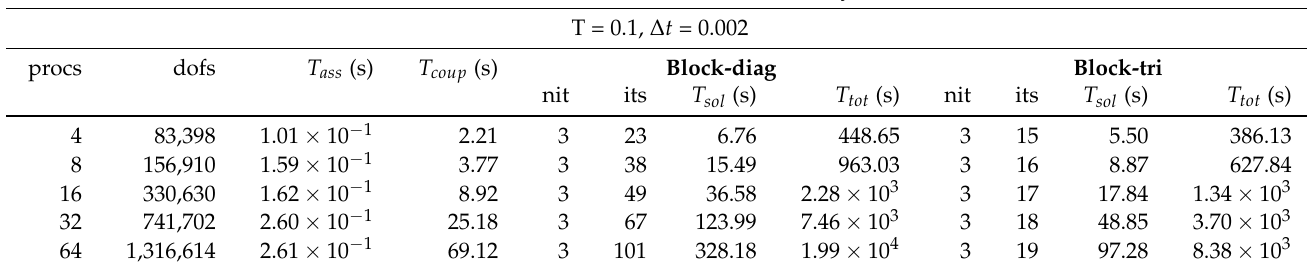
Table 4. Weak scalability for the nonlinear solid model. The simulations are run on the Shaheen cluster. Same format as Table